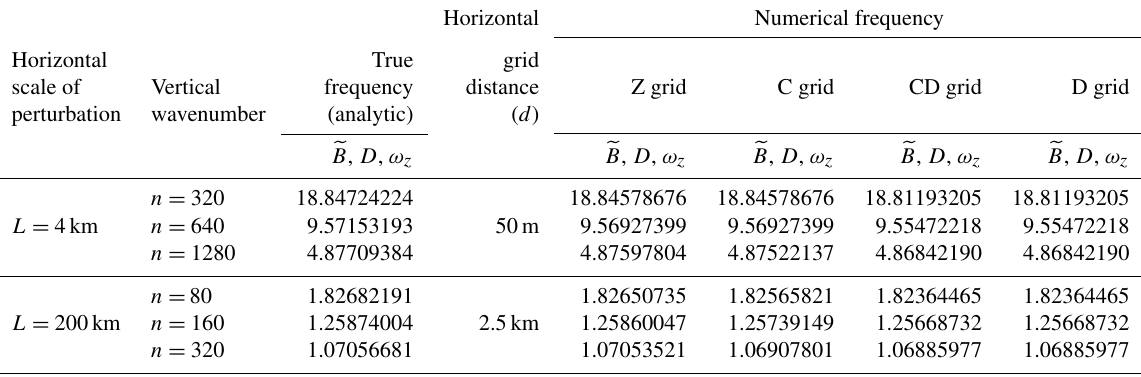
Table 3. True and numerically obtained frequencies from the simulations for the Z, C, CD and D grids using a horizontal grid spacing of d = L/ 80. The unit for the frequency is 10 − 4 s − 1 . The horizontal wavenumber for these cases can be obtained from 2 π/L .